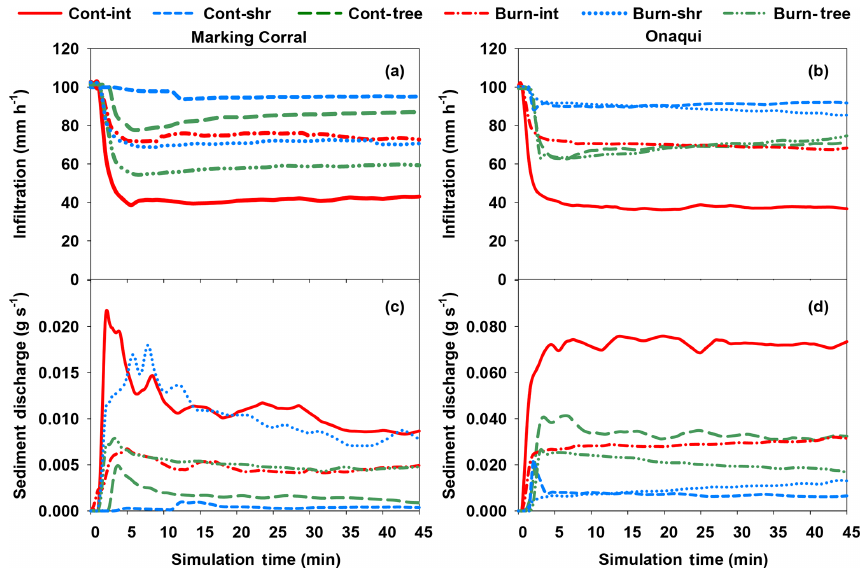
Figure 3. Example infiltration ( a : Marking Corral; b : Onaqui), calculated as applied rainfall minus measured runoff, and sediment discharge ( c : Marking Corral; d : Onaqui) time series data generated from a subset of the small-plot rainfall simulation dataset. Example subdataset is from wet-run rainfall simulations in untreated (cont) and burned (burn) interspace (int), shrub coppice (shr), and tree coppice (tree) microsites at the Marking Corral and Onaqui study sites 9 years following prescribed fire. The data illustrate the long-term impacts of burning and associated changes in surface conditions on infiltration and sediment discharge. Figure modified from Williams et al.